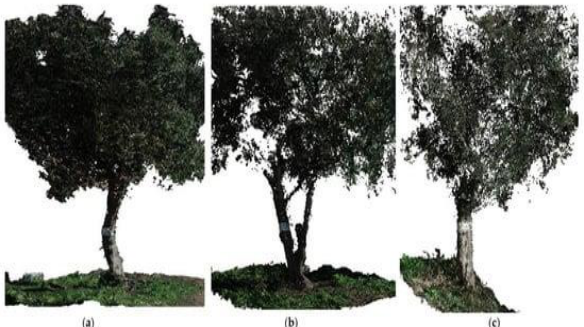
Figure 2. 3D point clouds of sample trees surveyed by the circular flights (Moreira et al.,